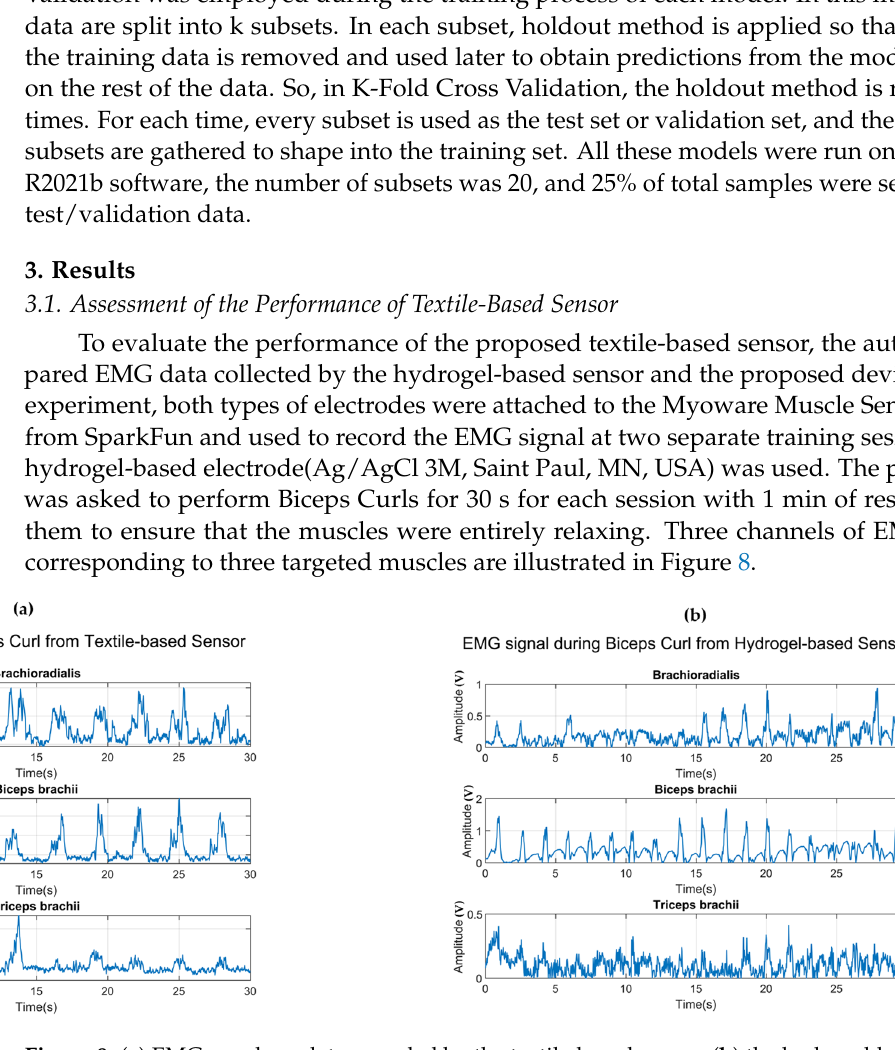
Wrist Curl for the fi rst 30 s, Biceps Curl for the next 30 s, and Dumbbell Kickback for